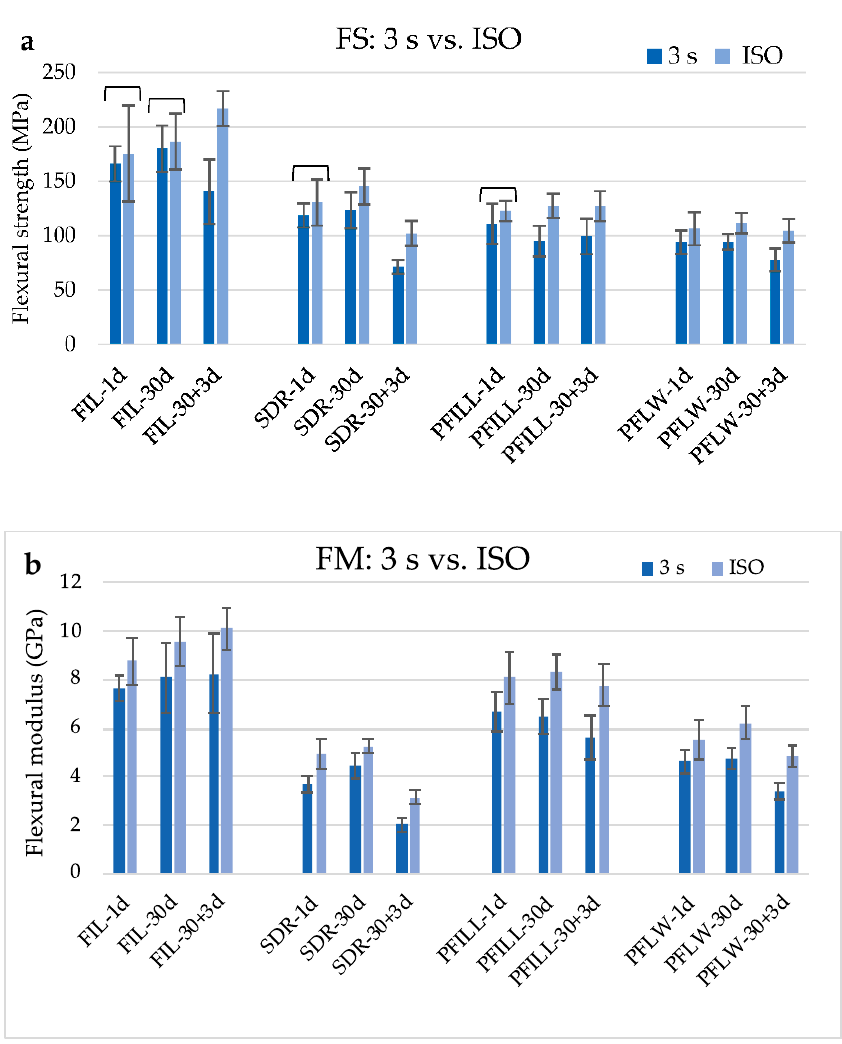
Figure 4. Comparison of ( a ) flexural strength and ( b ) flexural modulus of tested materials polymerized according to the ISO protocol and the top specimens polymerized with 3 s protocol (mean values ± 1 standard deviation). Brackets indicate statistically homogeneous groups for comparison of ISO and 3 s protocol ( p < 0.05).